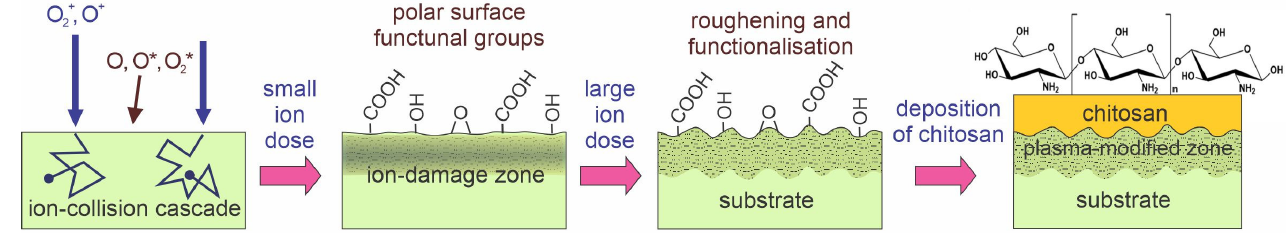
Figure 4. Evolution of surface morphology and polar groups upon treatment with low-pressure oxygen plasma and simultaneously bombarded with O 2+ and O + ions in pulses. oxygen plasma and simultaneously bombarded with O 2+ and O + ions in